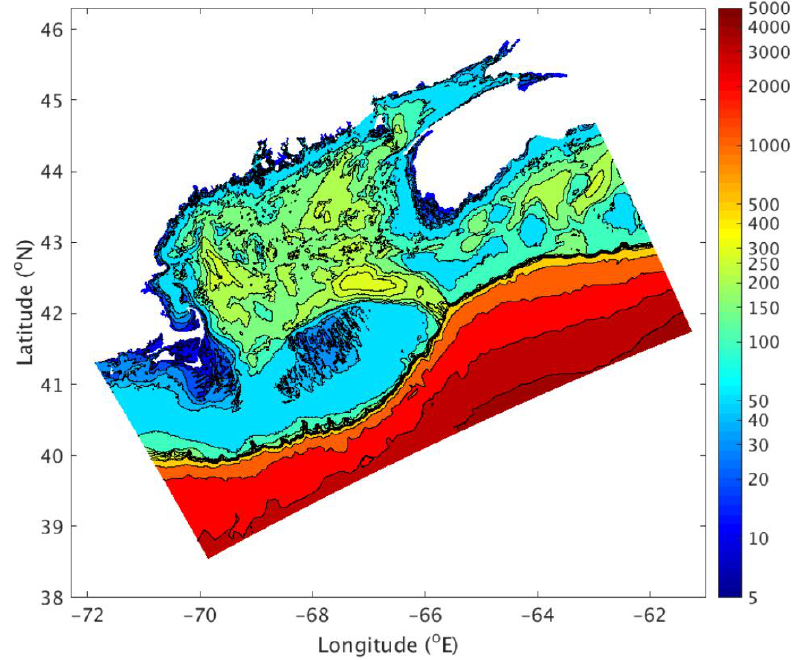
Figure 2. Bathymetry of the model grid. The color bar unit is meter.